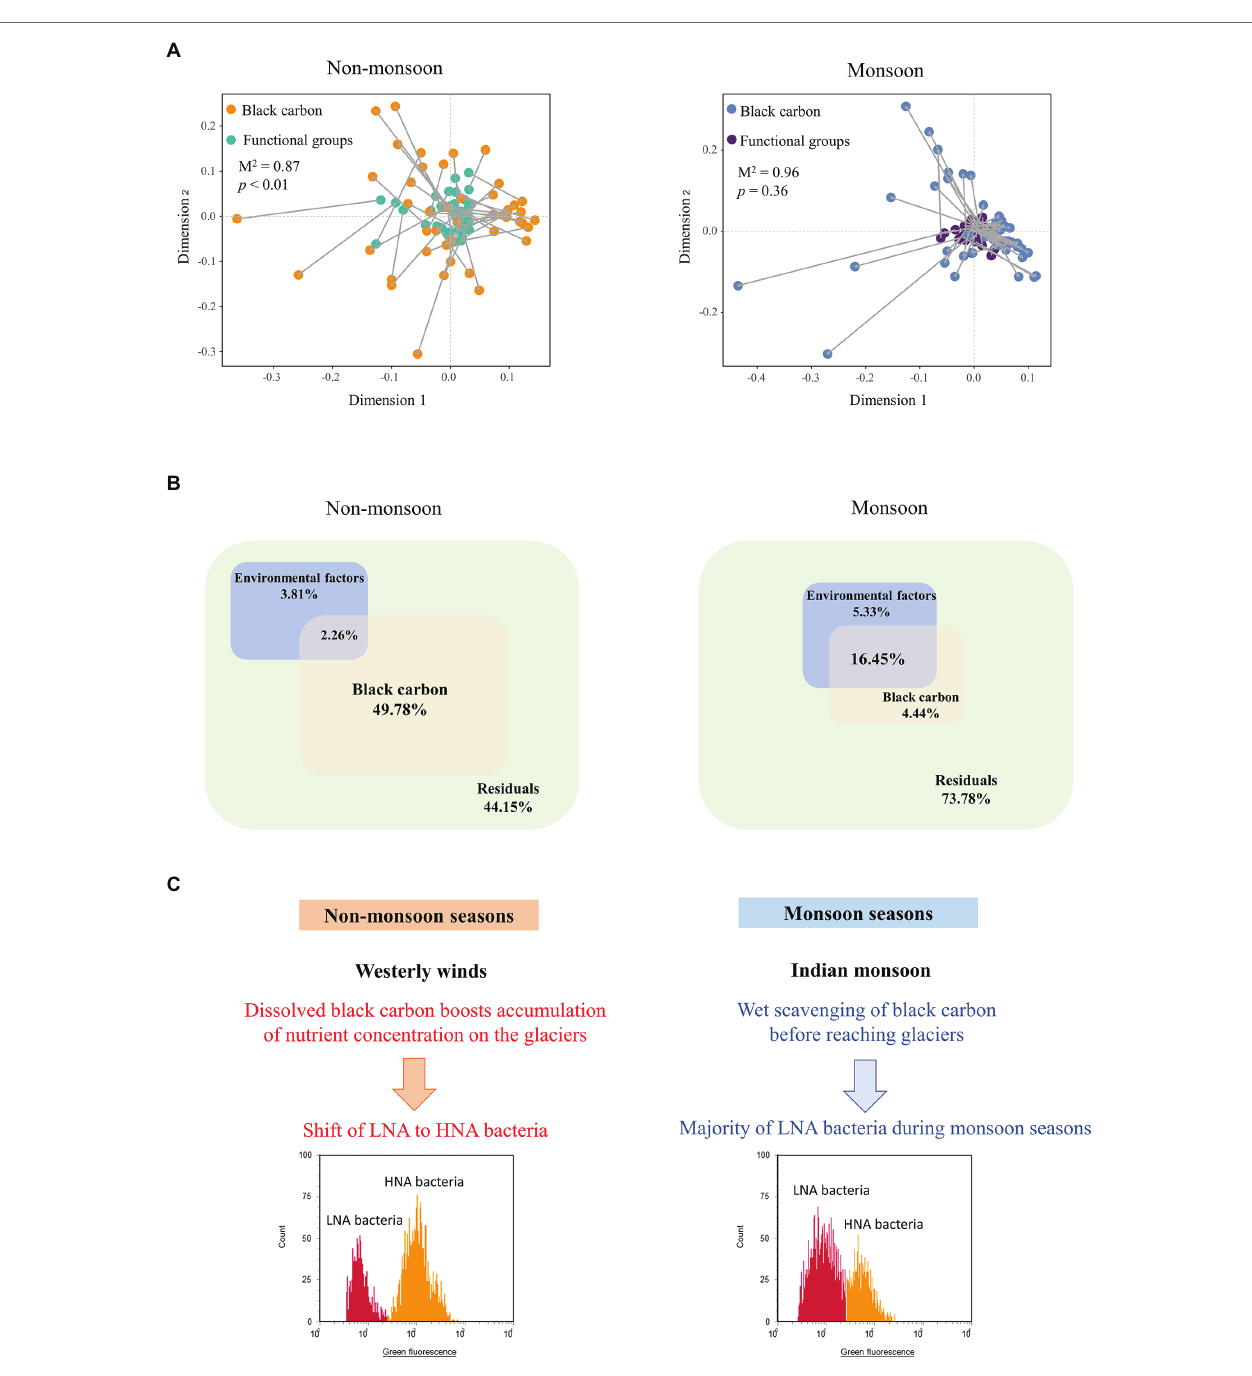
early-warning detection of microbiological effects of